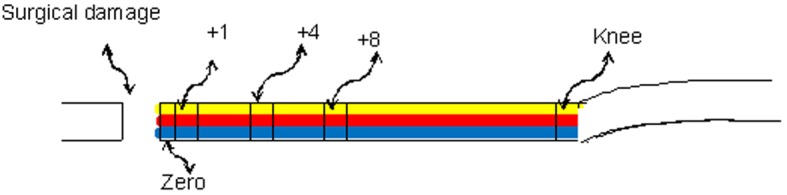
Schema indicating the counting positions (zero, +1, +4 +8 and knee) and the level of evaluations: periosteal (yellow), media (red) and endostea (blue).